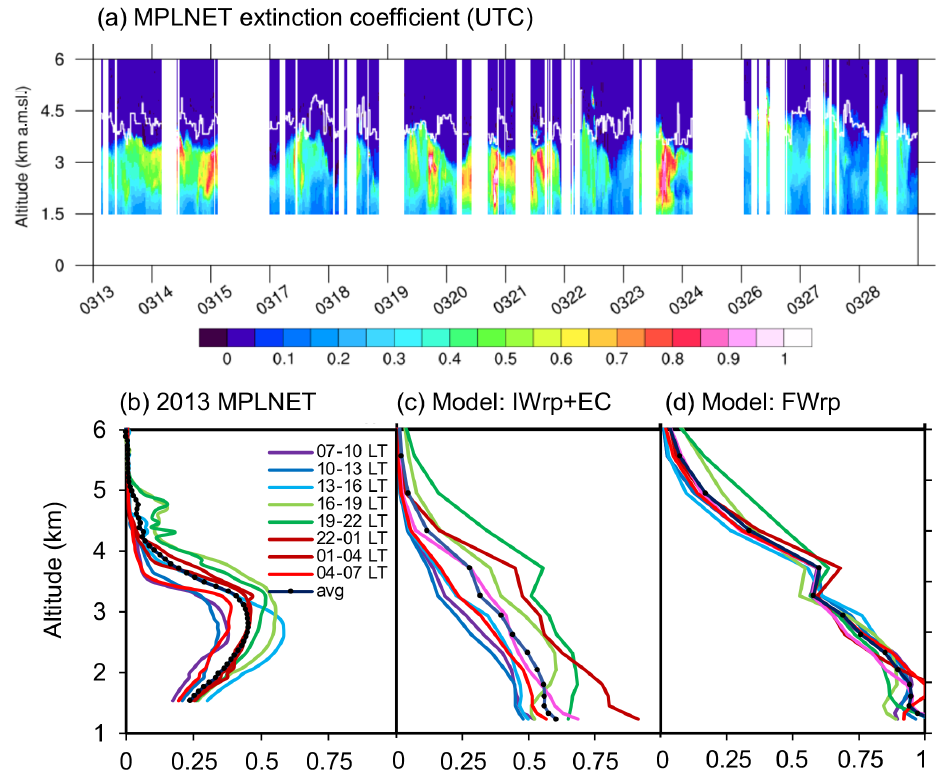
Figure 4. (a) Vertical extinction coefficient profiles between 13 and 28 March 2013 at the DAK station from MPLNET with boundary layer height (white), (b) MPLNET 3-hourly average extinction coefficient, (c) IWrp + EC 3-hourly averaged model output, (d) FWrp 3-hourly averaged model